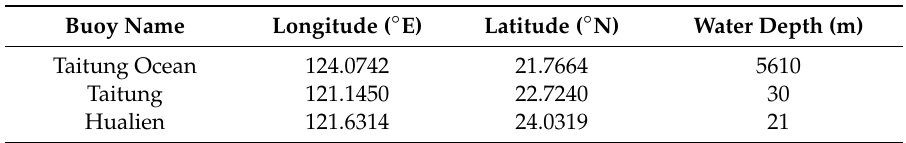
Table 1. Information on wave